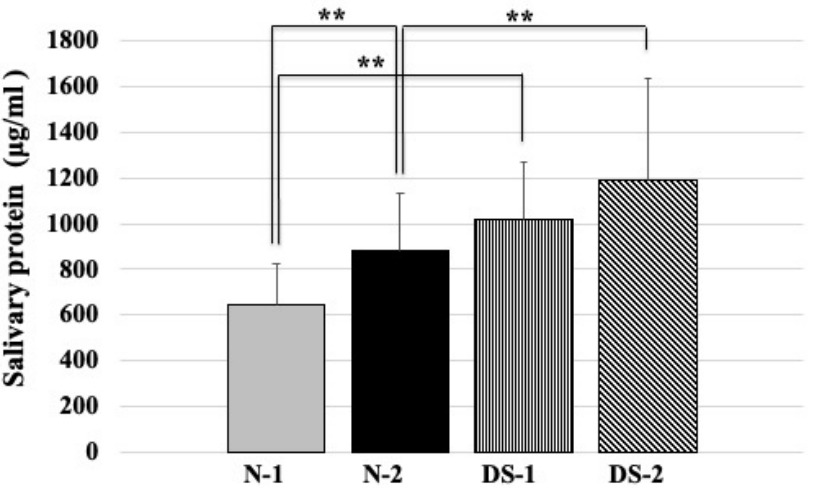
Figure 3. Comparison of total salivary protein concentrations between the Down syndrome (DS) and normal (N) groups. The DS and N groups were subdivided according to age, with the first group consisting of DS (DS-1) and normal (N-1) subjects under 20 years of age, and the second group consisting of DS (DS-2) and normal (N-2) subjects over 40 years of age. The sex composition and mean age of the study groups are shown in Table 1. One-way ANOVA test results of comparing salivary protein concentration in four groups and the pairwise comparison using Scheffe’s test for all four groups. ** p < 0.01; F-value 14.11.